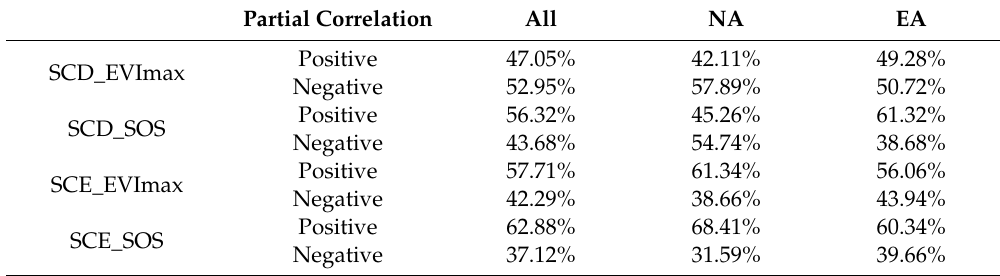
Table A4. Percentages of the partial correlation coe ffi cient between the start of growing season and snow cover duration (SCD_SOS), start of growing season and snow cover end date (SCE_SOS), annual maximum EVI and snow cover duration (SCD_EVImax), and annual maximum EVI and snow cover end date (SCE_EVImax) in the entire boreal region (All), North American boreal region (NA), and Eurasian boreal region